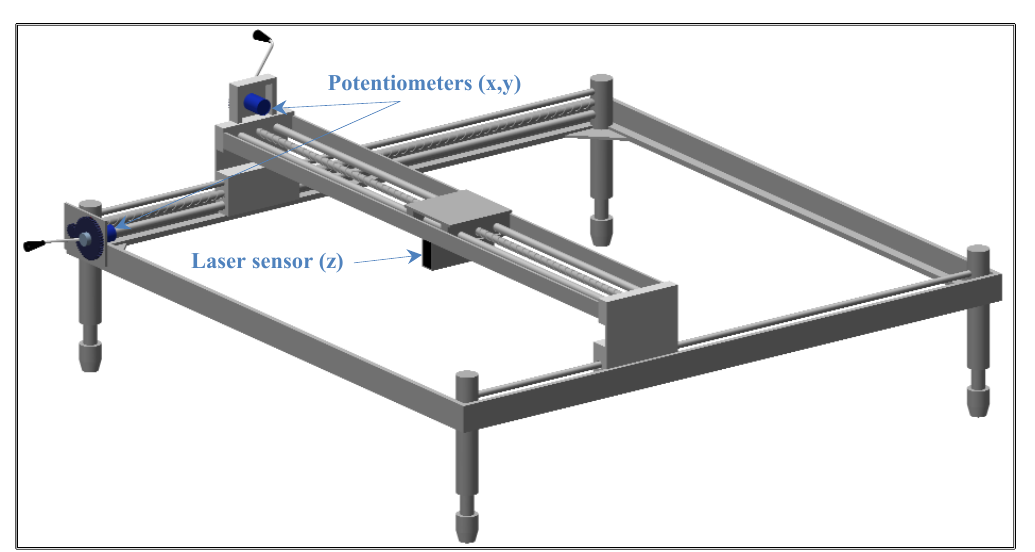
Figure 2. Laser microrelief profile meter for field studies of soil